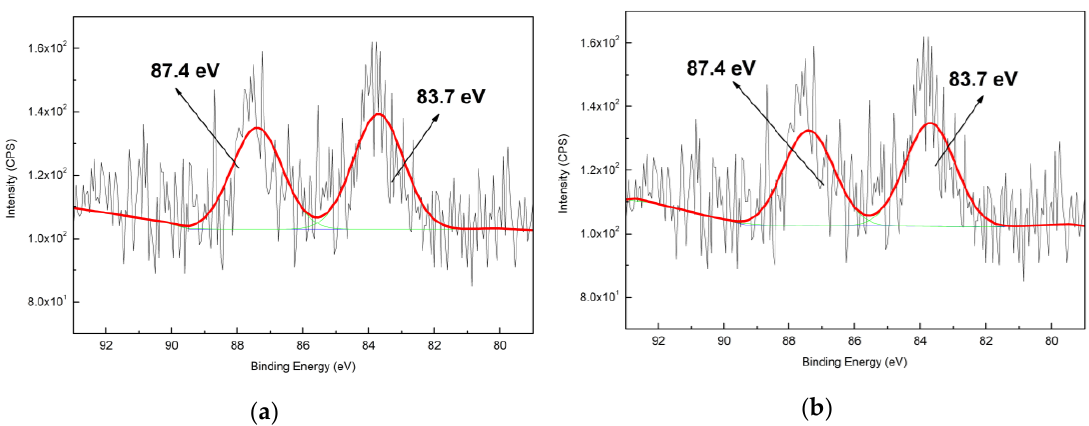
Figure 4. High resolution Au4f spectra of AuNPs immobilized zeolite: ( a ) Au@zeolite-APTES; ( b ) Au@zeolite-MPTES.